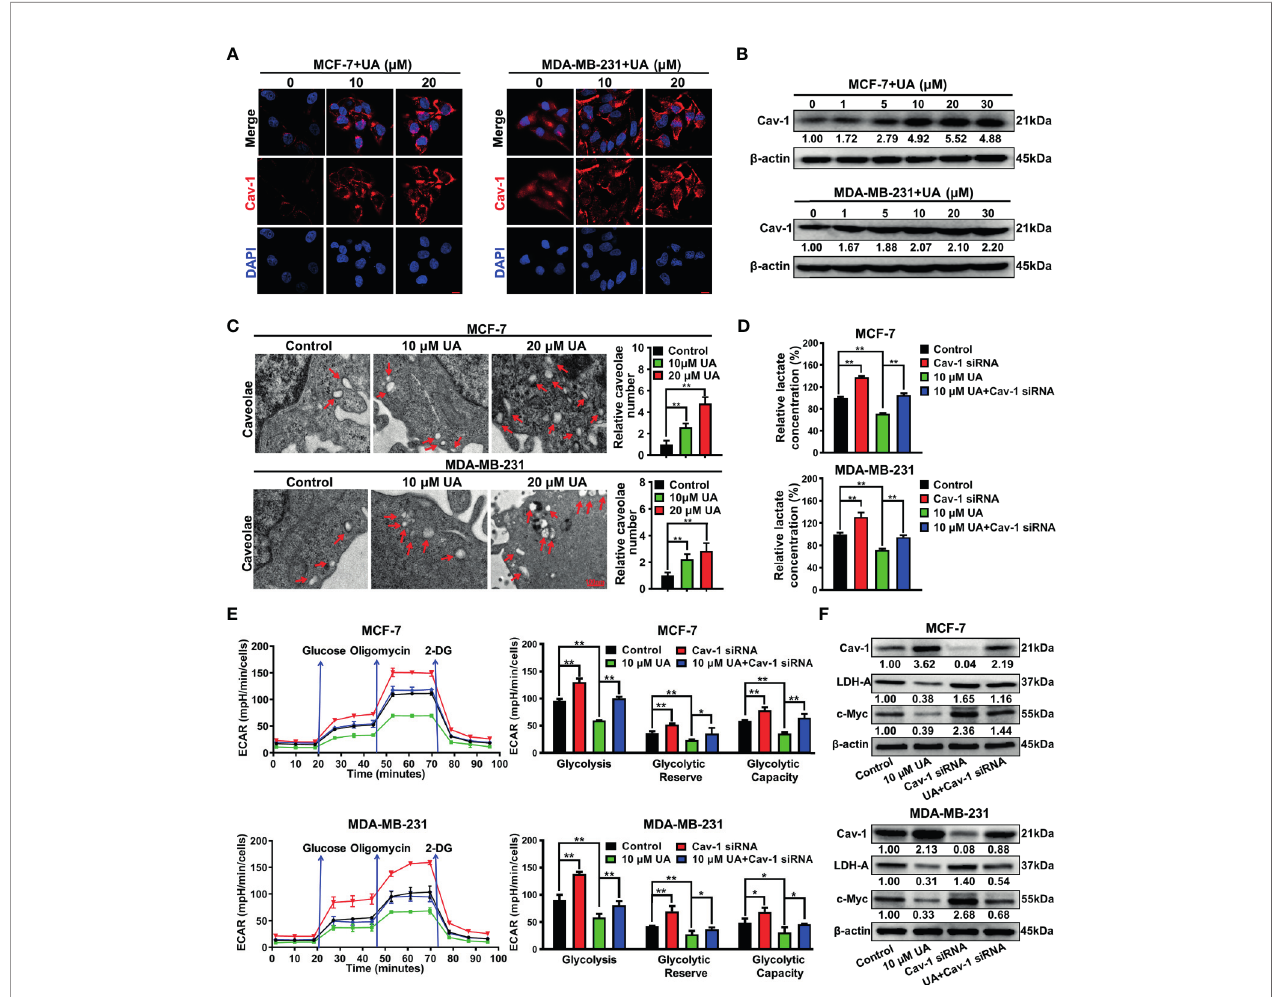
FIGURE 4 | Ursolic acid impairs the glycolytic metabolism of breast cancer cells by activating Cav-1 signaling. (A) MCF-7 and MDA-MB-231 cells were treated with 10~20 m M ursolic acid for 48 h Cell immuno fl uorescence assay was conducted to investigate the effect of ursolic acid on Cav-1 expression in breast cancer cells. Scale bar=10 m m. (B) The expression change of Cav-1 protein in MCF-7 and MDA-MB-231 cells after ursolic acid (1~30 m M) treatment for 48 h (C) MCF-7 and MDA-MB-231 cells were treated with 10~20 m M ursolic acid for 24 h The caveolae structures in breast cancer cells were observed by the transmission electron microscope. (D – F) Breast cancer cells were transfected with Cav-1 speci fi c siRNAs or treated with 10 m M ursolic acid for 48 h The combinational effects of Cav-1 knockdown and ursolic acid treatment on lactate production (D) , ECARs (E) and glycolysis-related proteins (F) of breast cancer cells were detected. N = 3. * p < 0.05. ** p <